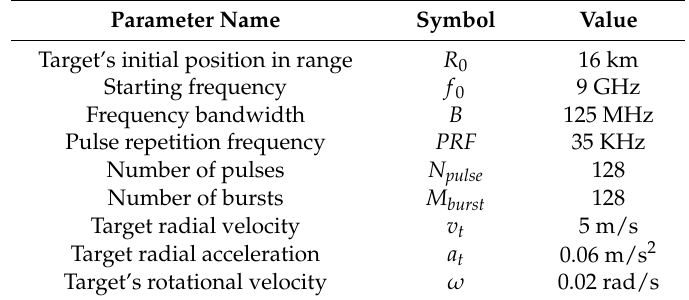
Table 1. The radar parameters for SFCW (Stepped frequency continuous wave) illumination.